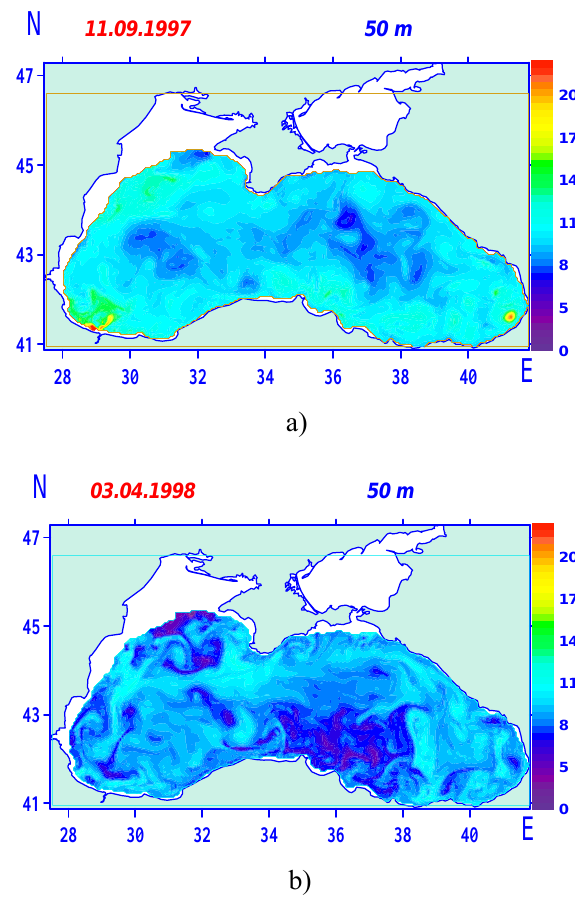
Figure 4 Temperature distribution on the depth 50m. Fig. 4. Temperature distribution on the depth